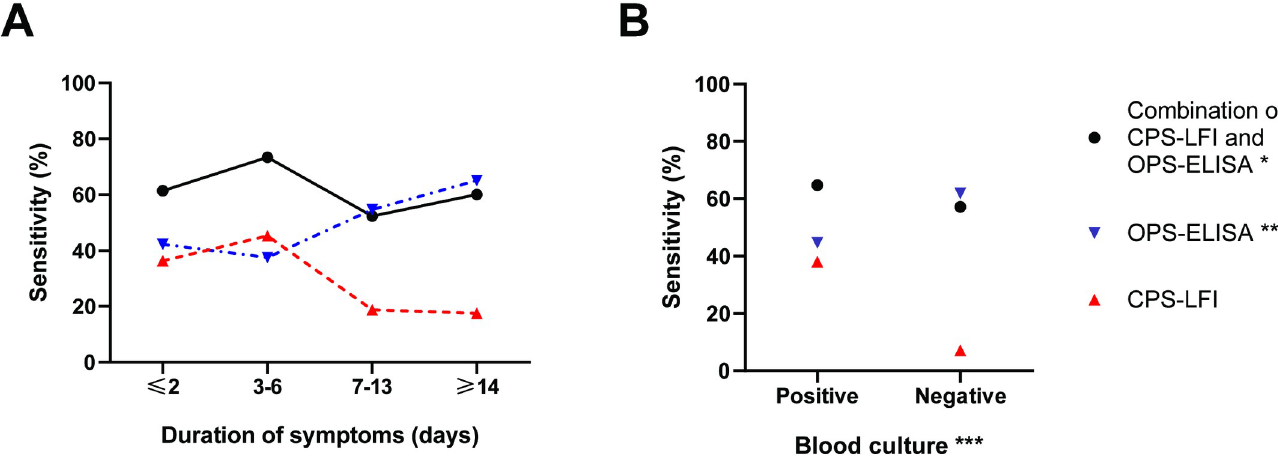
Fig 4. Sensitivity of the combination of the CPS-LFI and OPS-ELISA, OPS-ELISA alone and the CPS-LFI alone. (A) by duration of symptoms prior to admission and (B) by blood culture results in 192 melioidosis cases. � using OD cut-off value at a specificity of 95% (OD 3.100) �� using OD cut-off value at a specificity of 95% (OD 2.839) ��� Blood culture positive for B . pseudomallei .